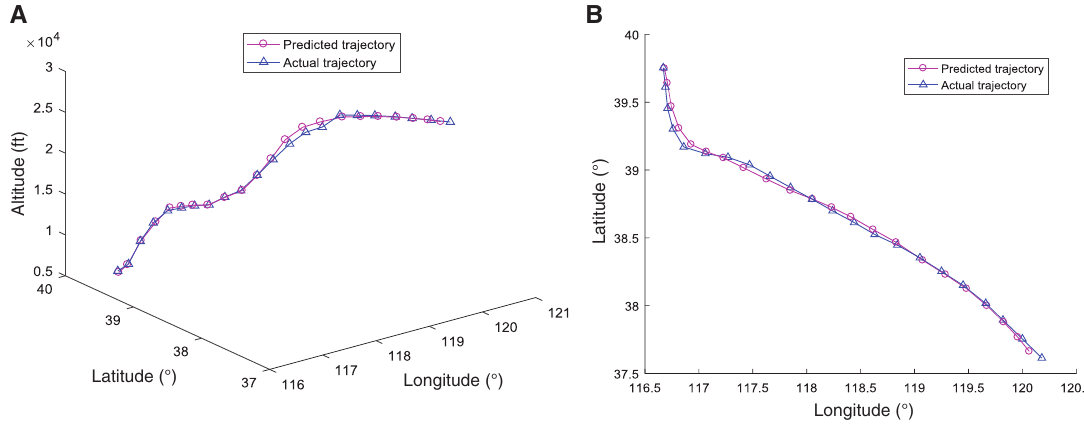
Figure 9: Trajectory Prediction of CDG4651 Flight. (A) 3D prediction of the trajectory and (B) latitude and longitude prediction of the trajectory.